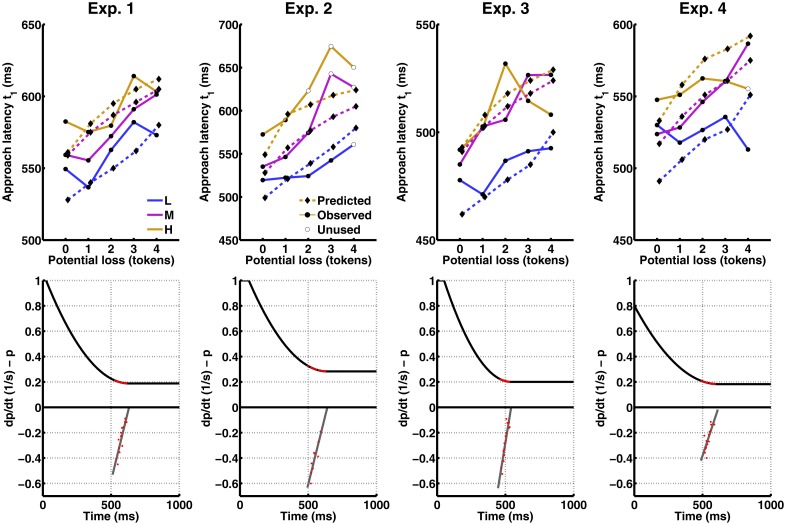
Comparison of model predictions with observed approach latencies.Upper panels: Predicted and observed approach latencies. Empty dots depict data points unused for the estimations (see Model and Methods). Lower panels: Reconstructed prior derivative (grey) and prior distribution (black). The prior derivative is scaled by the current catch rate and multiplied with current potential loss to derive the derivative of the expected loss (red curves in Fig 2). Red dots on the prior derivative depict data points used for the linear fit. Red dots on the prior depict range of predicted approach latencies.